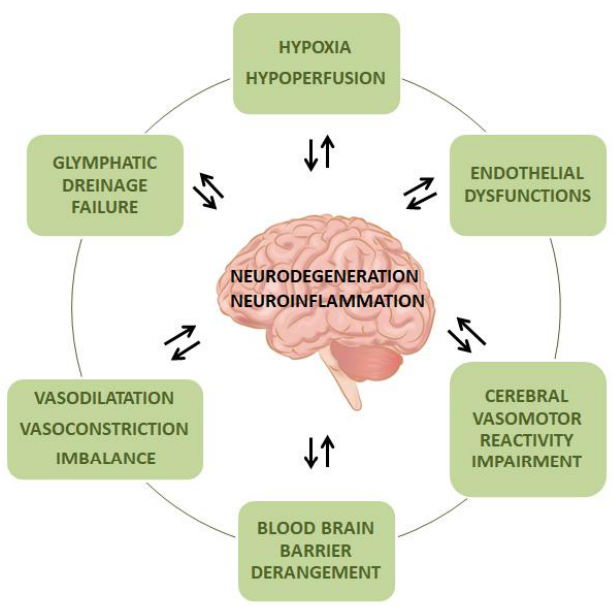
Figure 1. The figure shows the main pathophysiological mechanisms that link neurodegenera- tion/neuroinflammation and small vessel